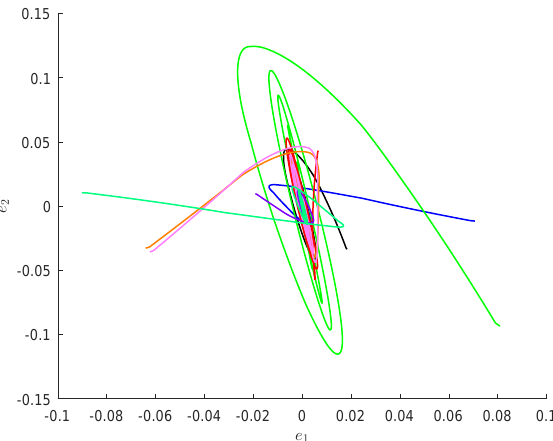
Figure 3. Phase trajectories of the errors e 1 and e 2 in Example 1, for 8 initial values (depicted with different colors). Best viewed in color.